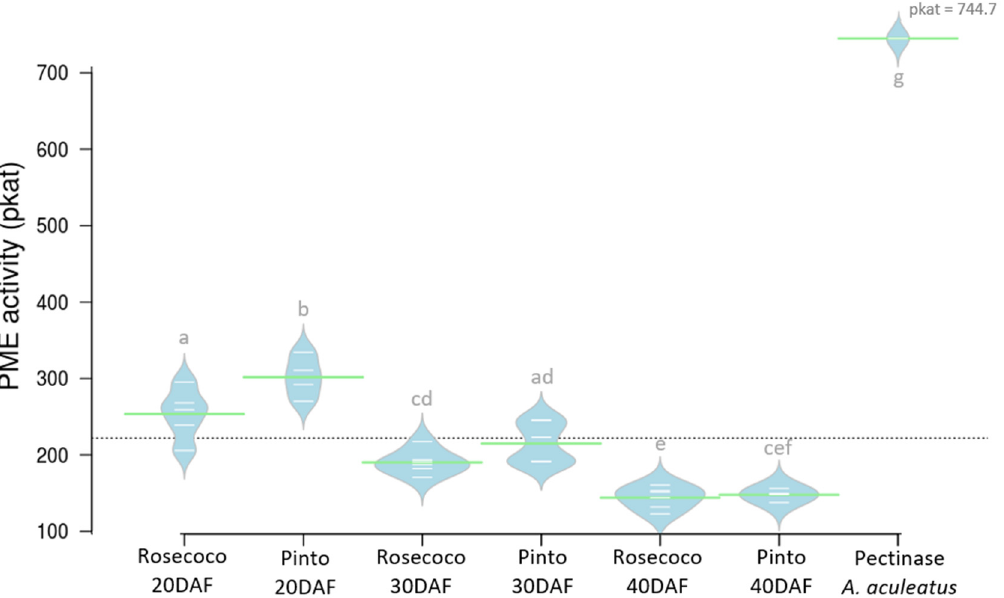
Figure 1. Bean plot showing the activity of the PME enzyme in developing seeds of fast-cooking (Rosecoco) and slow-cooking (Pinto) P. vulgaris varieties. Green lines indicate the sample means, white lines represent individual data points, and polygons represent the estimated density of the data. The dashed horizontal line shows the overall mean. Means with similar letters were not significantly different at p <